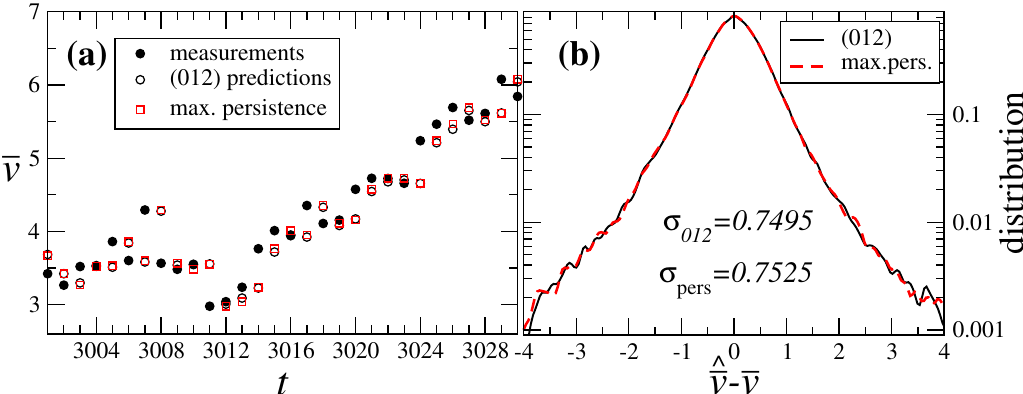
Figure 5. ( a ) Wind speed forecasts 15 min ahead using an ARIMA ( 0,1,2 ) model (open circles) and the maximum persistence model ( ˆ¯ v pers ( t + 1 ) = ¯ v ( t ) , red squares) compared with the measured values (full circles). ( b ) Distribution of the deviations between predicted and measured values for both the ARIMA ( 0,1,2 ) model (black line) and the maximum persistence model (red dashed